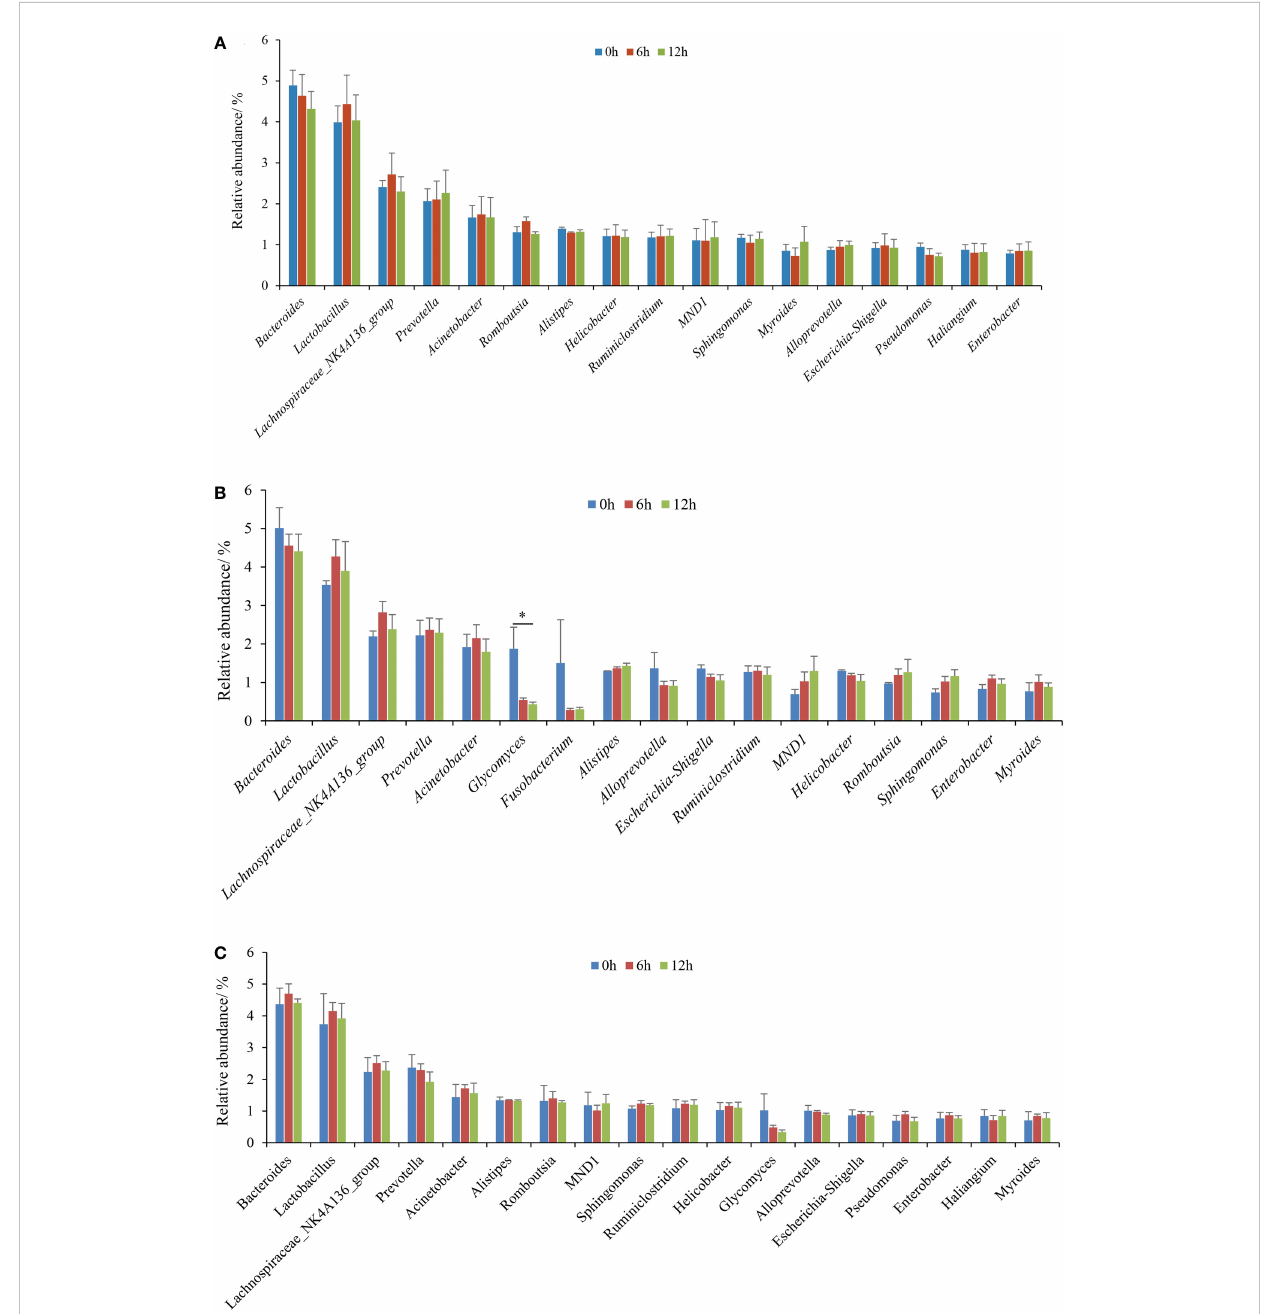
FIGURE 4 The dominant (top 15, according to the average relative abundances of the three parallel samples for each gastrointestinal tissue in each treatment) genera of gastrointestinal microbiota of pond-cultured Japanese fl ounder. (A) stomach; (B) pyloric caecum; (C) gut. * represented signi fi cant differences for the same genus among the different sampling times ( p <